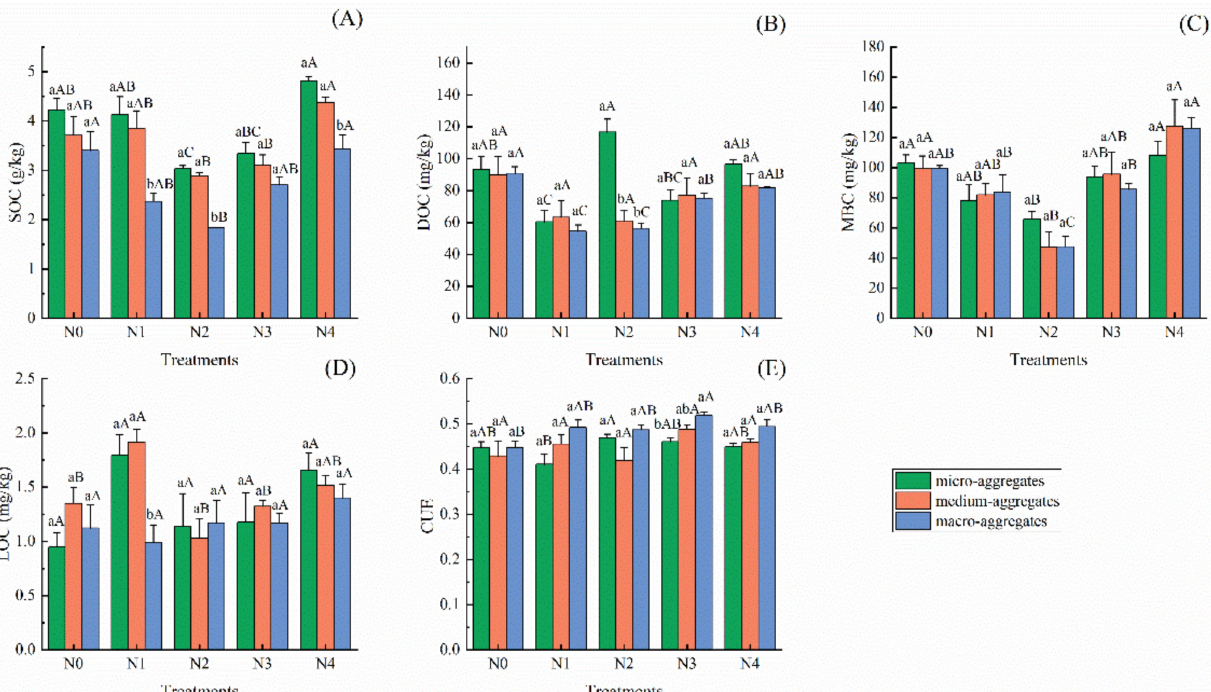
Figure 1. Effects of N addition on SOC ( A ), DOC ( B ), MBC ( C ), LOC ( D ), and CUE ( E ) in three soil aggregates. The green, orange, and blue bars indicate the changes of five indexes in micro-aggregates, medium aggregates, and macro-aggregates, respectively. The error bar is the standard error of mean. Different small and capital letters above bars indicate significant differences among different soil aggregates and N addition rates at the level of p < 0.05. SOC: soil organic carbon; DOC: dissolved organic carbon; MBC: microbial biomass carbon; LOC: labile organic carbon; CUE: microbial carbon use